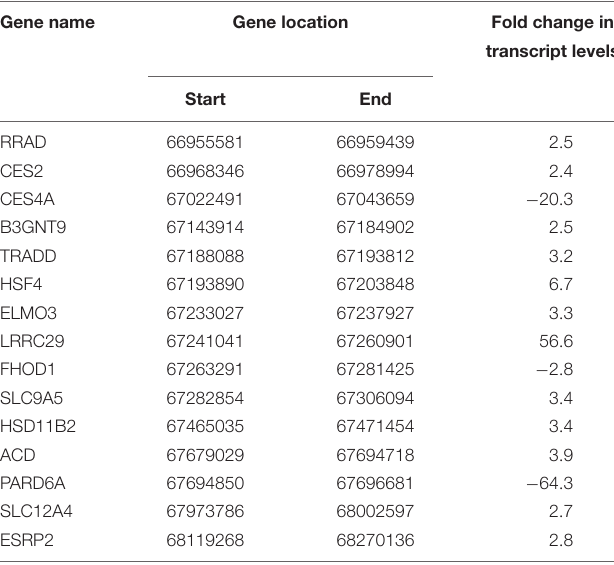
TABLE 4 | List of known genes on 16q22 locus with more than twofold change in transcript levels between BEC20W and BEC40W cells, as represented in Figure 4